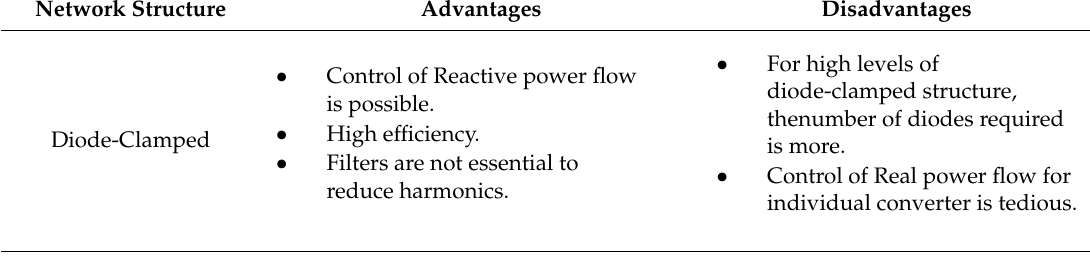
Table 2. State of art PV grid inverter topologies of